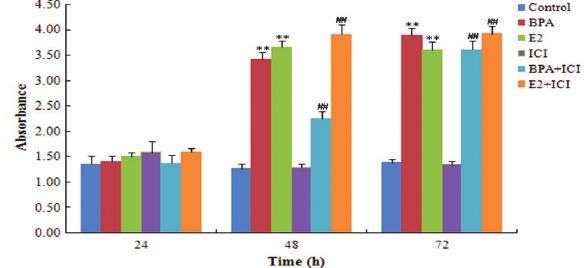
Figure 6. Effect of bisphenol A (BPA) and estradiol (E2) on telomerase activity in HepG2 cells. Cells were treated with BPA or E2 alone or in combination with the anti-estrogen ICI 182,780 (ICI). Telomerase activity was assessed by the PCR-telomeric repeat ampli fi cation protocol (TRAP). Data are reported as means ± SD. **P o 0.01 compared to control group; ## P o 0.01 compared to ICI group (one-way ANOVA test).